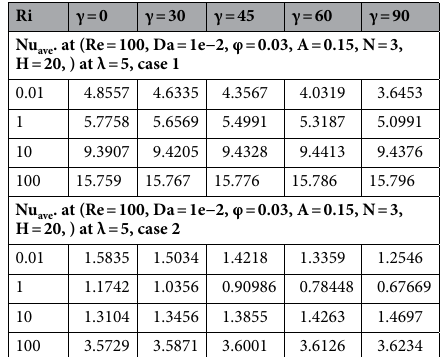
Ri Re = 100 Re = 200 Re = 300 Re = 500 Nu ave . at (, Da = 1e−2, φ = 0.03, A = 0.15, N = 3, H = 20, ) at λ = 5, case 1 0.01